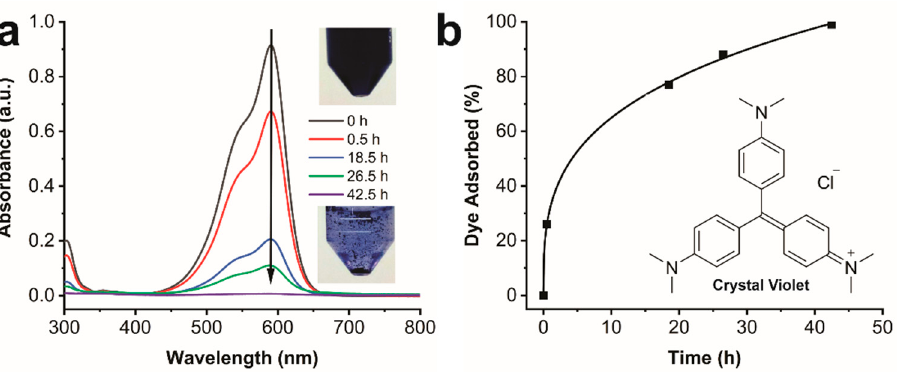
Figure 9. Crystal Violet (CV) dye adsorption by the ISA24 aerogel. ( a ) UV-Vis spectra of CV recorded after various times. ( b ) The amount of CV dye adsorbed by the ISA24 aerogel over time.